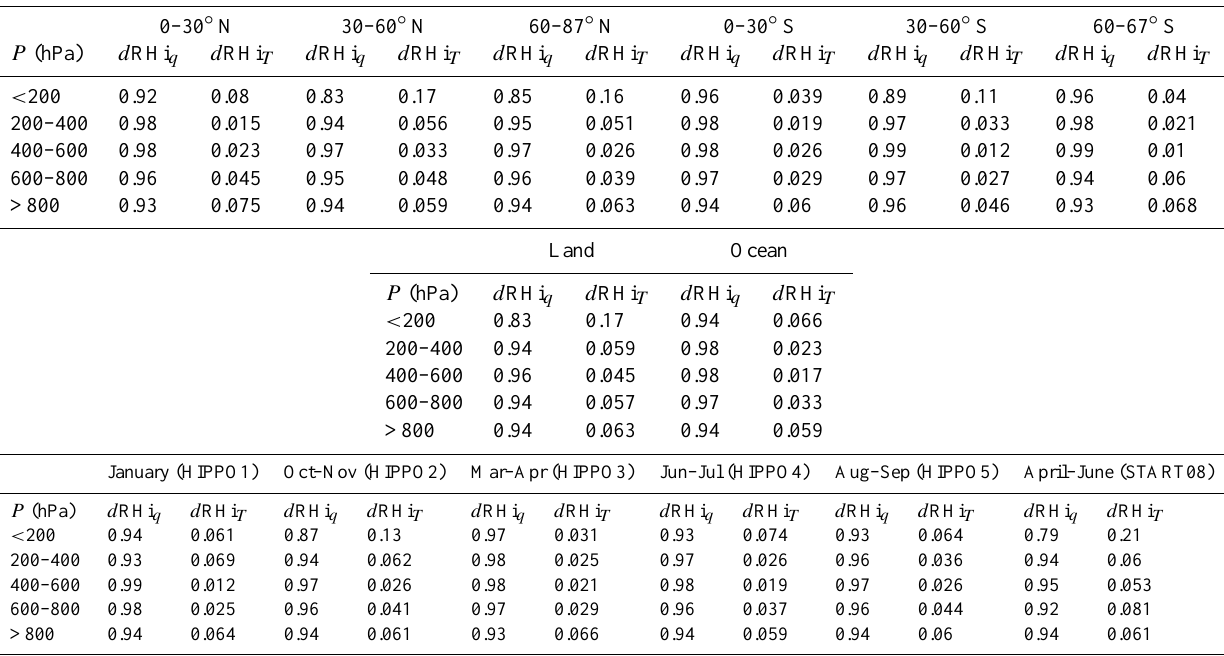
Table 3. Contributions of H 2 O and T horizontal variabilities to RH horizontal variabilities at various P ranges at different latitudes, over land and ocean and at different times of a